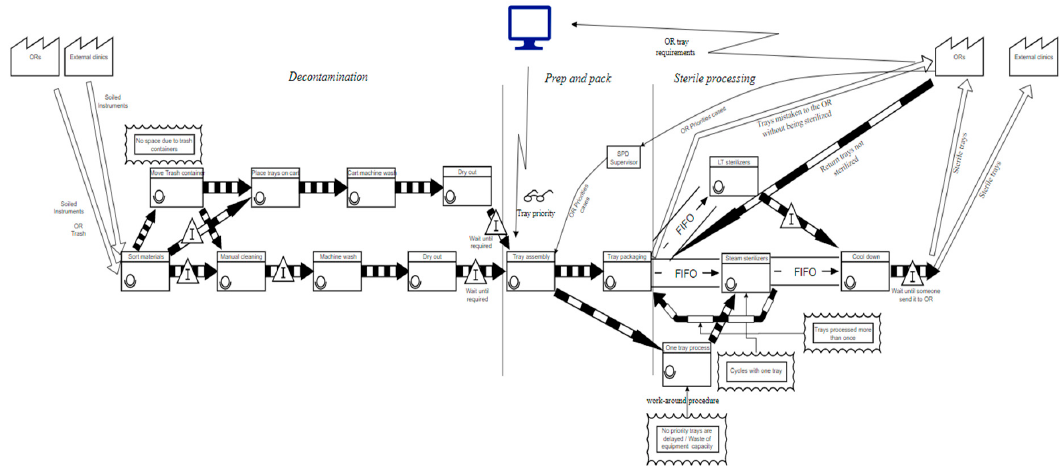
Figure 4. Current State Value-Stream Mapping (VSM) of the SPD.